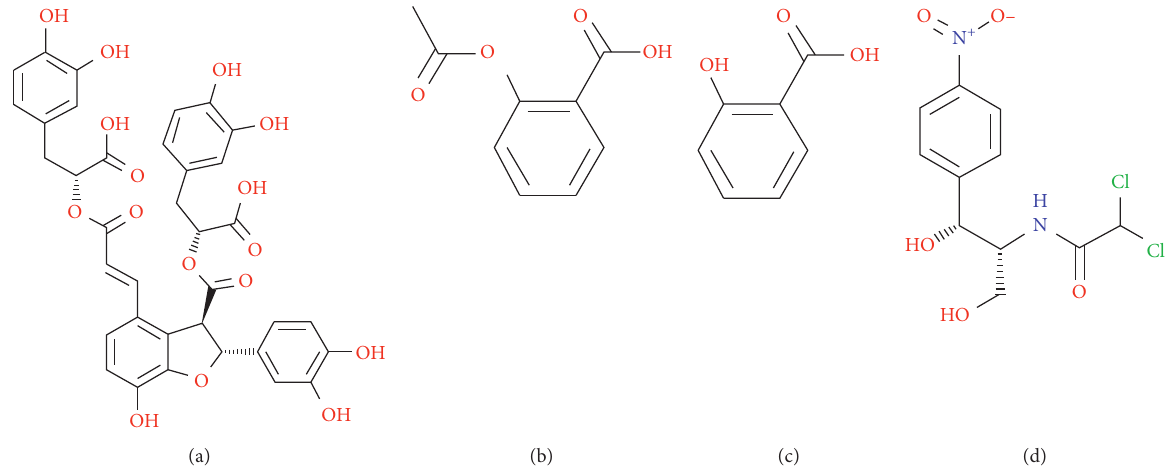
Figure 1: Chemical structures of (a) salvianolic acid B, (b) acetylsalicylic acid, (c) salicylic acid, and (d) chloramphenicol. Table 1: MS/MS ion acquisition parameters of Sal B, ASA, SA, and IS.